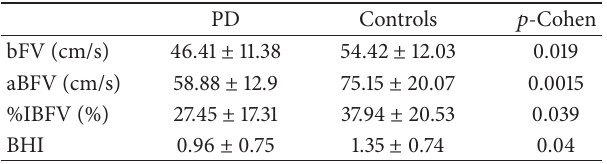
Table 5: Cerebral hemodynamic data for PD patients without OH and